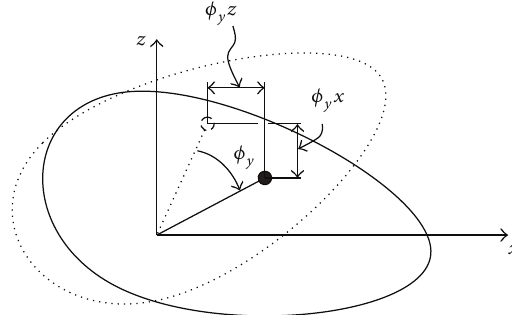
Figure 4: Rigid torsion of the beam cross-section.